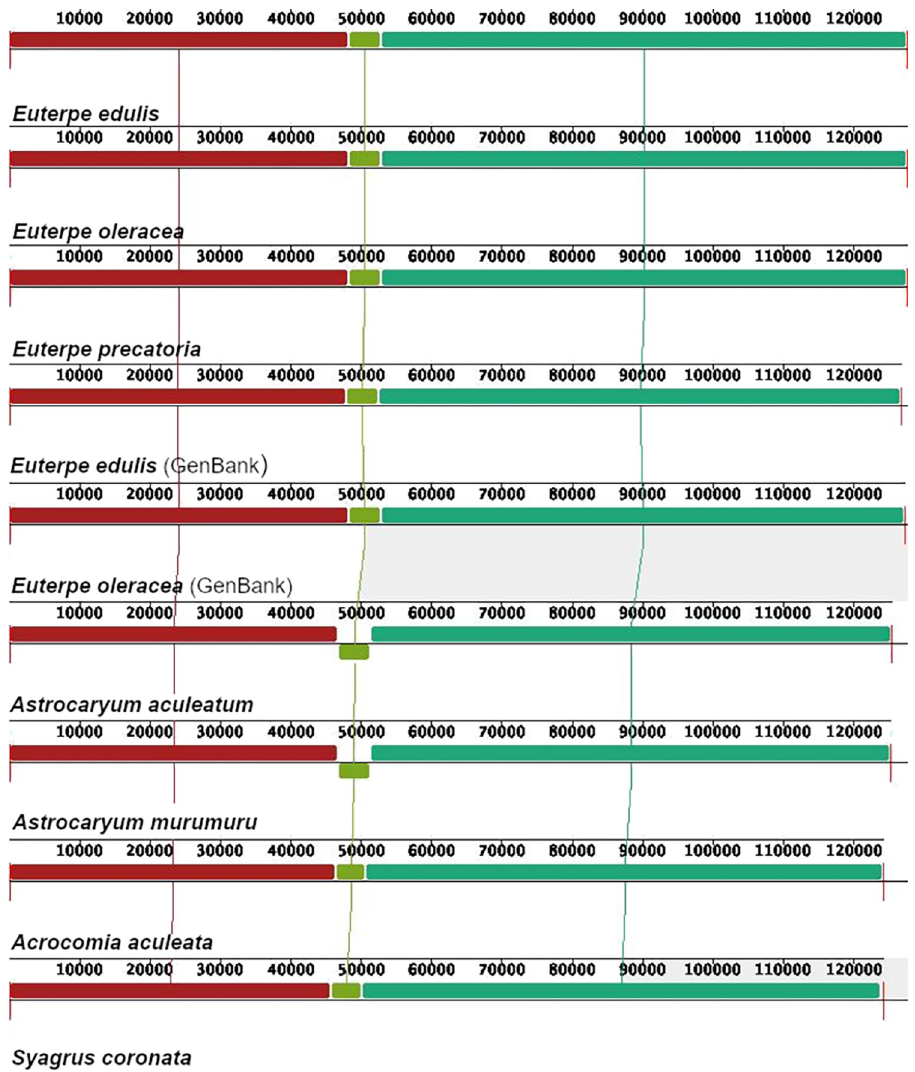
Fig 2. Synteny and divergence in the SSC size detected in Arecaceae chloroplast genomes using the Mauve multiple-genome alignment program. A sample of nine different chloroplast genomes is shown. Color bars indicate syntenic blocks and the lines indicate the correspondence between them. Blocks on the top row are in the same orientation, while blocks on the bottom row are in inverse orientation.